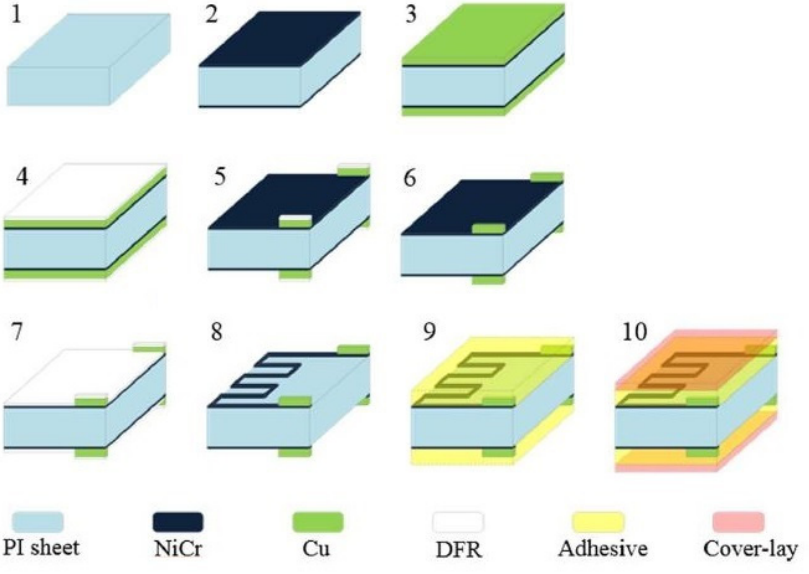
Figure 3. Schematic diagram of the fabrication steps of the Ni–Cr/Polyimide-based wearable heart- beat sensors [131]. beat sensors